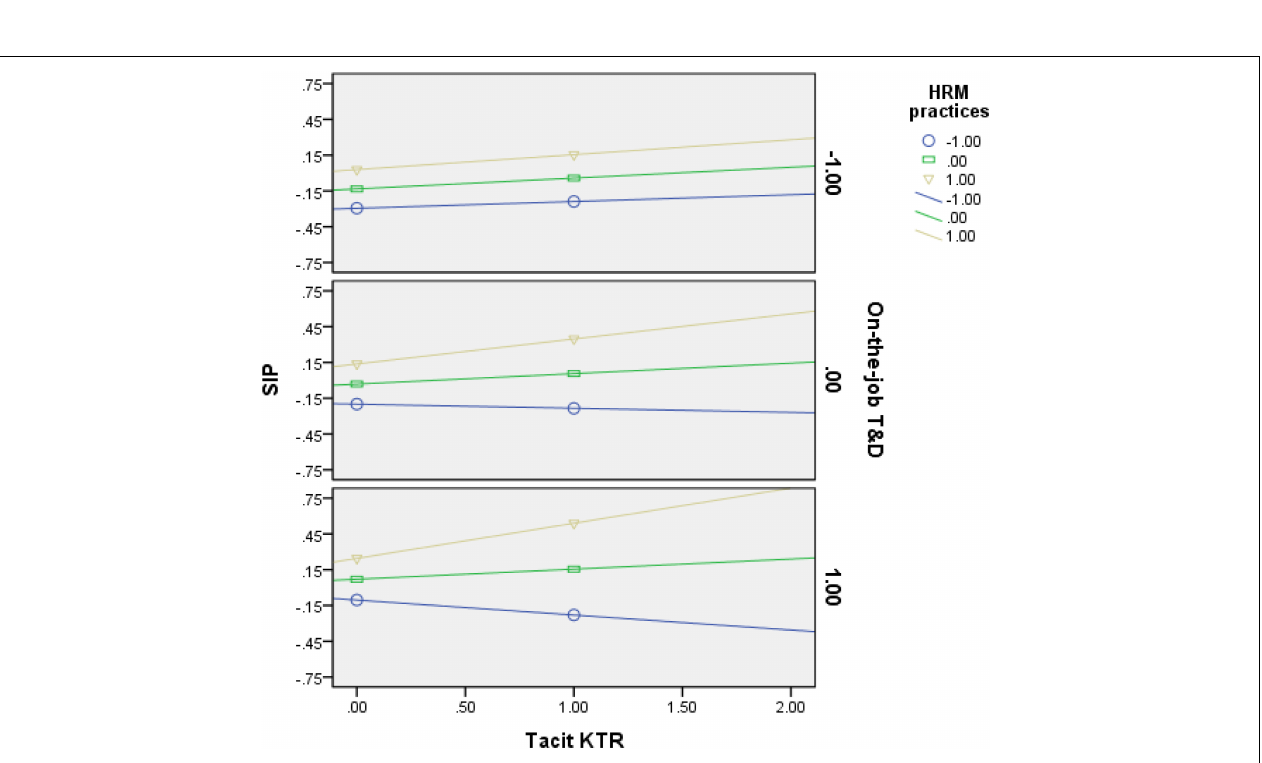
Frontiers in Psychology |